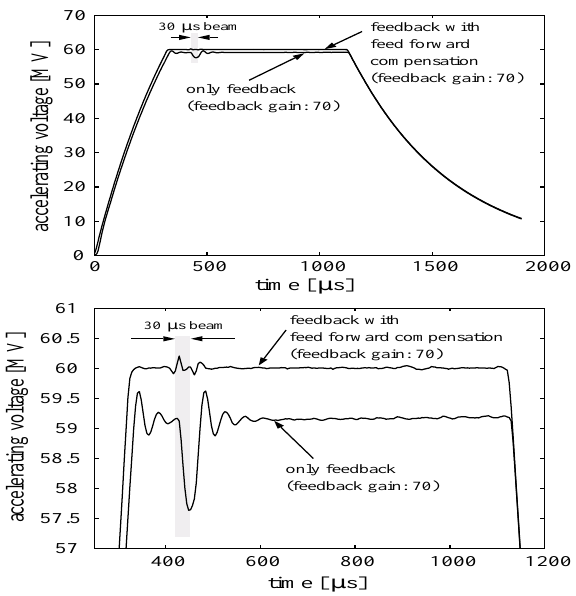
FIG. 29. Field regulation of the vector sum of eight cavities without and with adaptive feedforward. The lower graph shows an enlarged view of the plateau